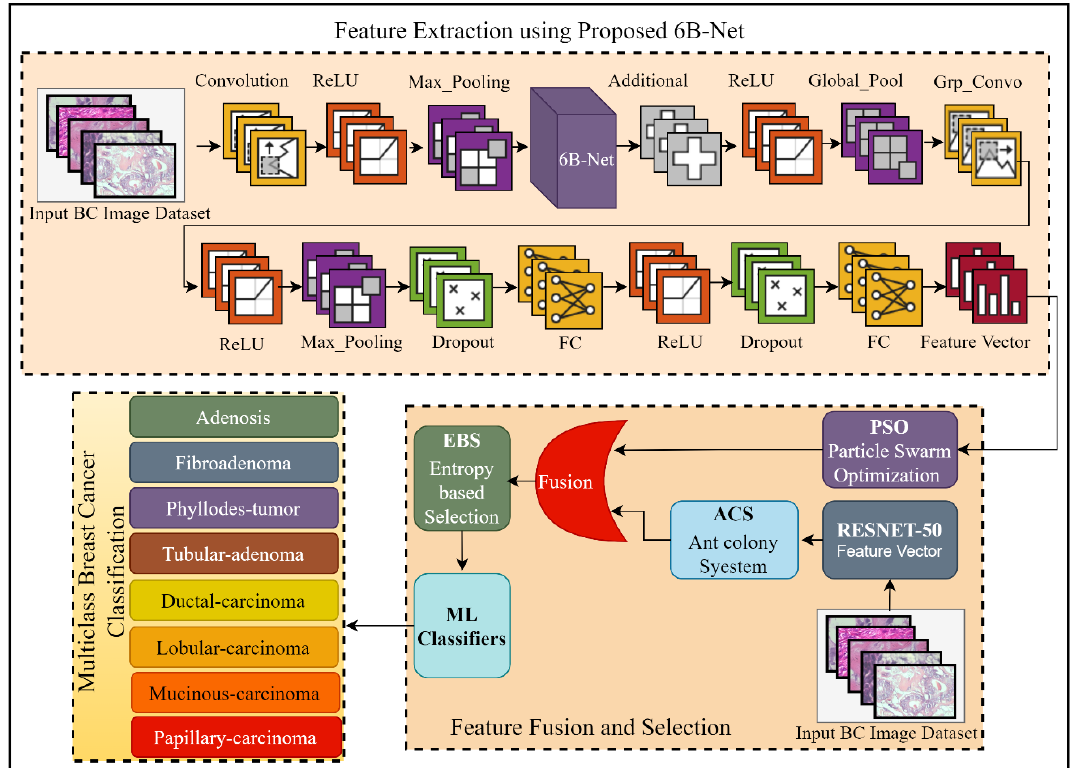
Figure 1. The framework of the proposed fusion and selection-based method of breast cancer multi- class classification. The feature extraction using the proposed 6B-Net block represents the feature extraction process; feature fusion and selection block represent the proposed feature fusion and selection process; and finally, the classification block represents the eight classes of breast cancer. Here BC is representing breast cancer, FC is representing the fully connected layer, and ReLU is the rec- tified linear unit.